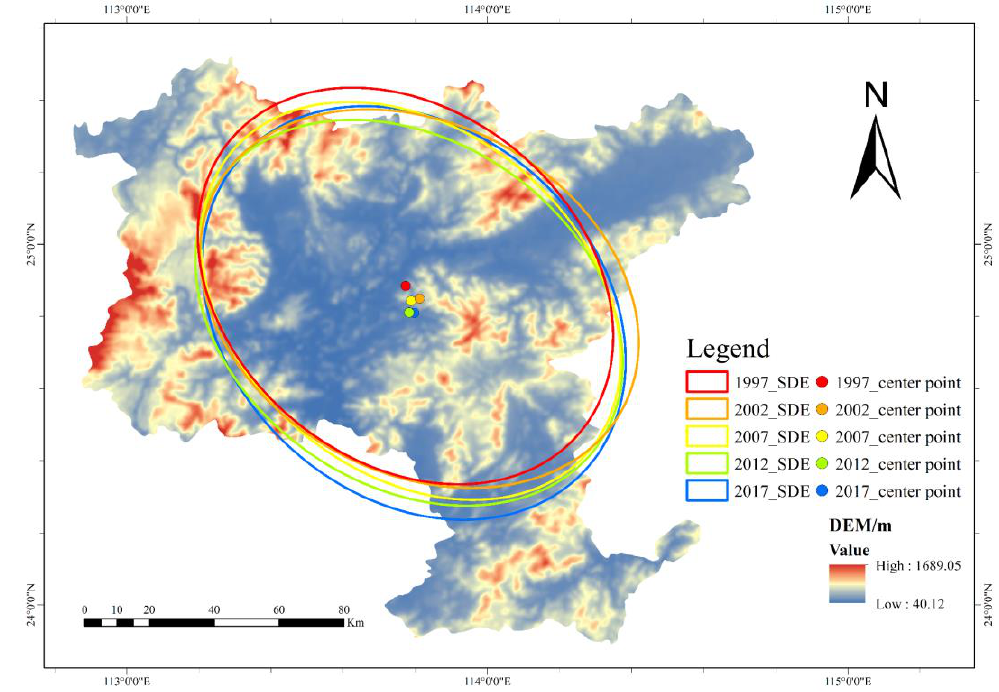
Figure 5. Spatial dynamic changes of NPP in Shaoguan from 1997 to 2017.